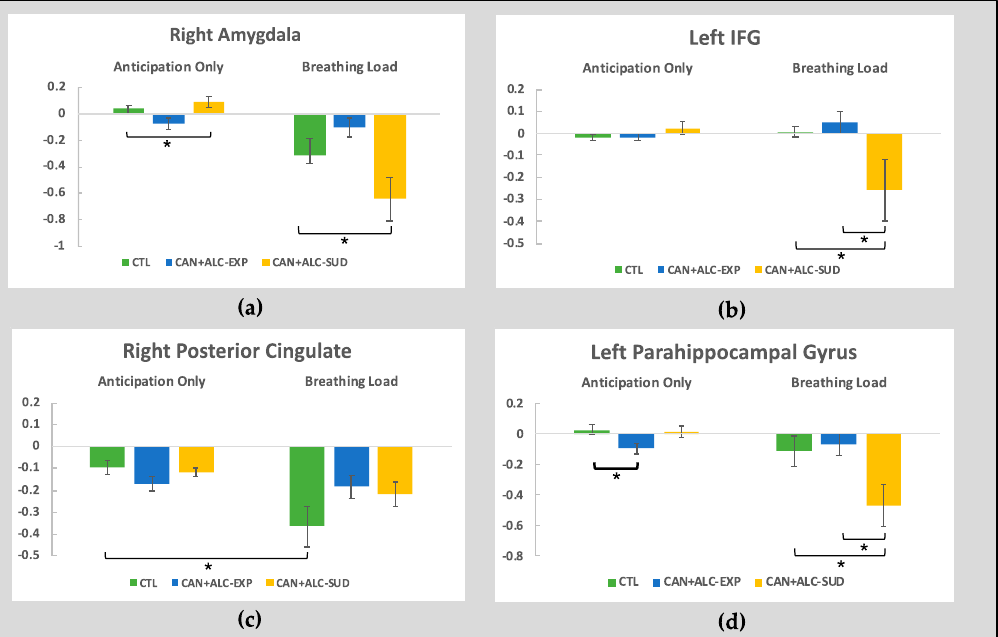
Figure 2. Neuroimaging results from the group by interoception condition interaction in ( a ) the right amygdala; ( b ) the left inferior frontal gyrus; ( c ) the right posterior cingulate; and ( d ) the left parahippocampal gyrus. * indicates significant differences.